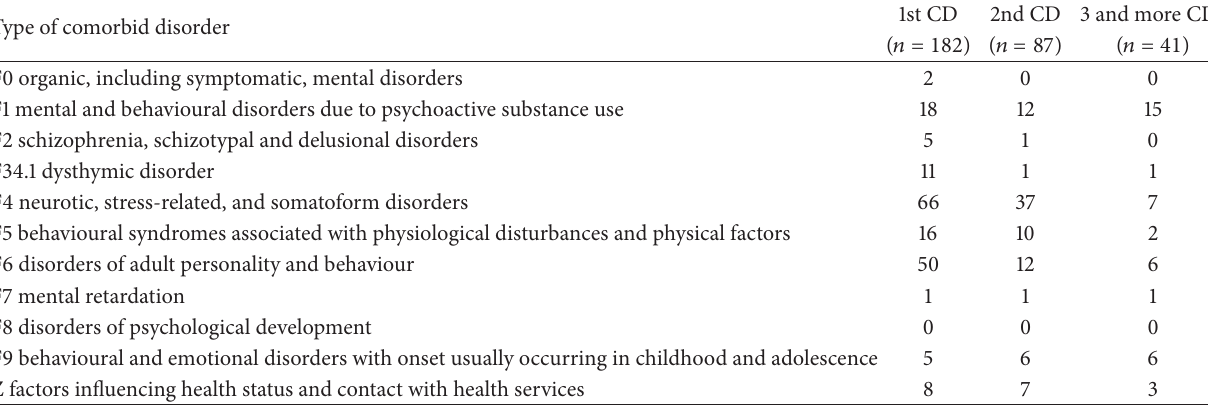
Table 2: Types and frequencies of comorbid disorders